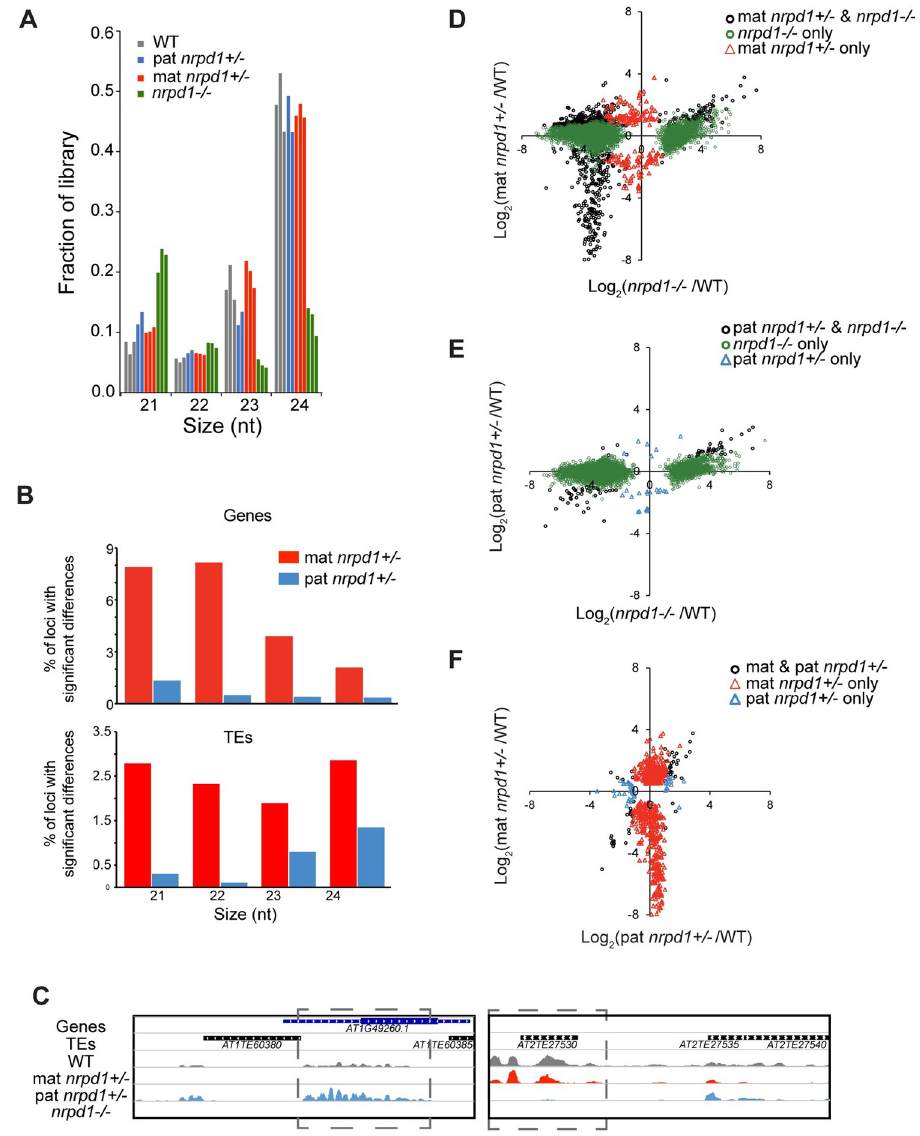
Fig 1. Impact of loss of maternal, paternal, or both copies of NRPD1 on endosperm sRNAs. (A) Loss of maternal or paternal NRPD1 does not substantially alter the endosperm sRNA pool. Fraction of aligned sRNA reads in each size class in the indicated genotypes. (B) Examination of 21- to 24-nt sRNAs over genes or TEs shows that inheriting a mutant maternal nrpd1 allele has a greater impact than inheriting a mutant paternal nrpd1 allele. Percent of loci showing at least a 2-fold reduction in sRNA abundance and padj < 0.05 according to DESeq2 are indicated in red (mat nrpd1+/− ) or blue (pat nrpd1+/− ). Genes and TEs included in this tally have a normalized WT read count of 5 or higher. (C) Snapshots of loci with Pol IV–dependent 24-nt sRNAs that show a specific loss of sRNAs in mat (left) or pat (right) nrpd1+/− endosperm. (D–F) Comparisons of genic 24-nt sRNAs upon loss of maternal, paternal, or both copies of NRPD1 . Fold change as calculated by DESeq2. Only significant changes ( padj < 0.05) are plotted. Underlying data for Fig 1 A, B, and D–F can be found in S1 Data. Pol IV, polymerase IV; sRNA, small RNA; TE, transposable element; WT,